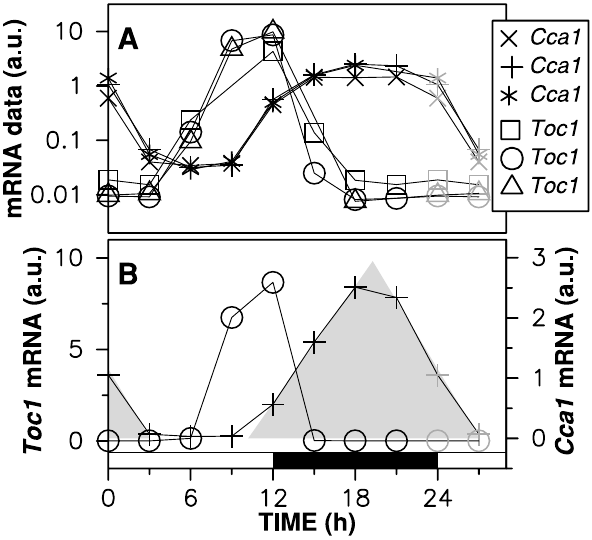
Figure 1. Microarray data recorded under 12:12 LD alternation. Time zero corresponds to dawn. (A) Experimental data points for the Cca1 and Toc1 mRNA time profiles [21] are drawn in logarithmic scale. Data points at zeitgeber time (ZT) 0 and ZT3 have been replicated in gray at ZT24 and ZT27. The target Toc1 and Cca1 profiles selected for subsequent analysis are shown with circles and pluses, respectively. These two profiles are also shown in linear scale in (B), where the shaded area illustrates the sawtooth shape of the Cca1 mRNA profile, which will be used later as evidence of a strongly saturated enzymatic degradation. This area has been obtained by fitting a straight line through Cca1 data points at ZT12, ZT15 and ZT18 on one hand and at ZT21, ZT0 and ZT3 on the other